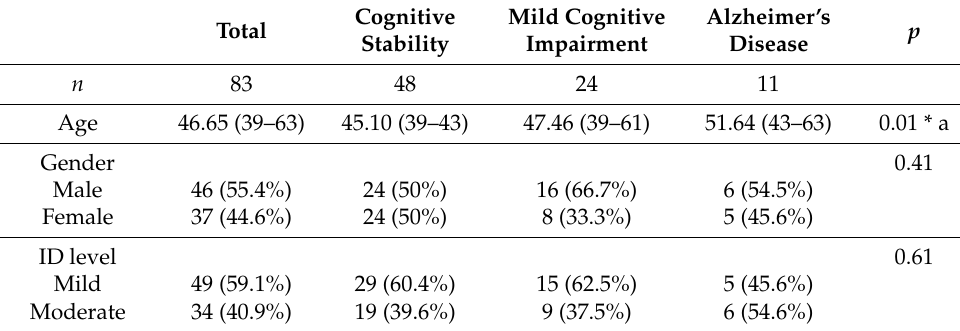
Table 4. Demographics of the primary diagnosis